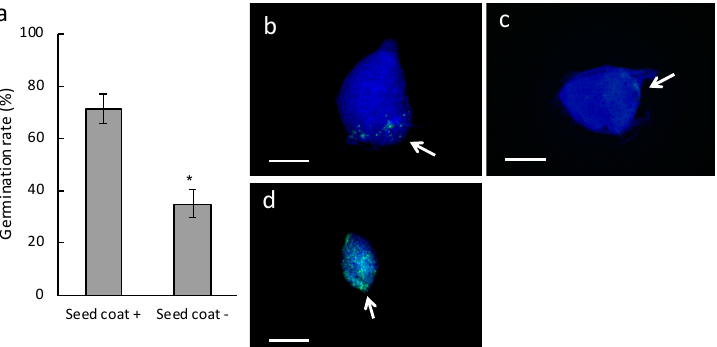
Figure 1. Seed germination of Bletilla striata inoculated with the symbiotic fungus Tulasnella sp. strain HR1-1. ( a ) Germination rate of B. striata seeds. Gray bars indicate the germination rate defined as the emergence of shoot apex at two weeks after sowing. Seed coat +, intact seeds; Seed coat − , seed coat-stripped seeds. Error bars represent standard errors of the means of five independent experiments. The asterisk shows significant difference between the treatments as determined by the Student’s t -test at p < 0.01. ( b – d ) Fungal colonization of B. striata seeds by Tulasnella sp. strain HR1-1. The images show two-week-old protocorms that were stained with calcofluor white (blue) and wheat germ agglutinin (WGA)-Alexa fluor-488 (green) to visualize the plant cell and fungal structures, respectively. ( b ) A successfully germinated intact seed. ( c ) An ungerminated intact seed. ( d ) A seed coat-stripped seed. Arrows indicate the suspensor end. Scale bars, 200 µm. 2.2. Germination Rate and Fine Observations of Seed Coat-Stripped Seeds of Bletilla striata Inoculated with the Symbiotic Fungus Sebacina Vermifera